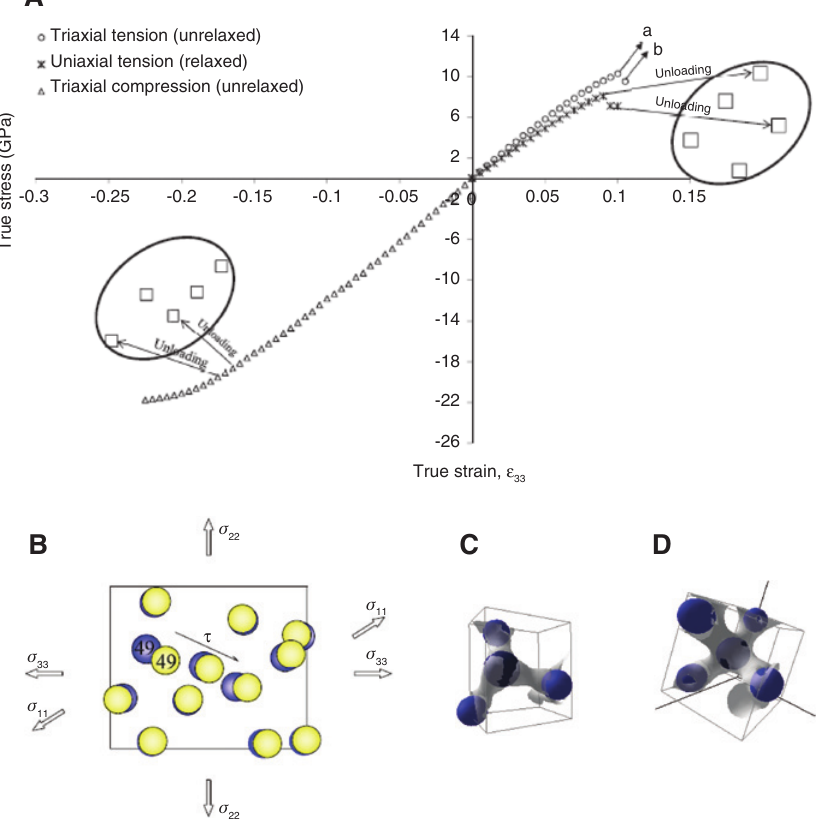
Figure 2: (A) The variation of the true stress as a function of true strain up to the yielding point of our a-Si sample under both relaxed (uniaxial tension) and unrelaxed (triaxial tension/compression) conditions, (B) the relaxed positions of some atoms around atom number 49 pertinent to steps a and b shown in (A), respectively, in blue and yellow colors, (C) atom number 49 at step a, and (D) atom number 49 at step